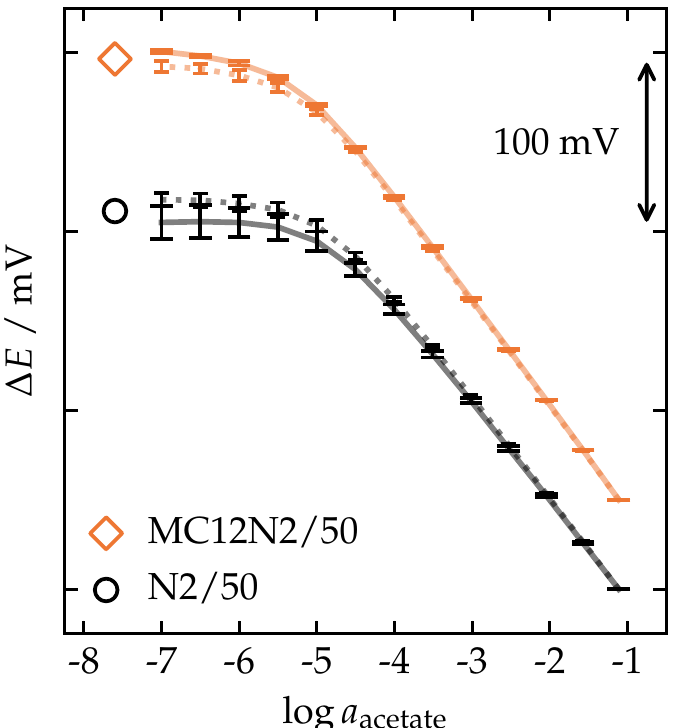
Figure 3. Potentiometric calibrations of sensors with either the best-performing ion-selective membrane or its corresponding control membrane. Potentials have been adjusted to separate membranes and so that each sensor in a group starts at the same potential at log a = − 1.11. Error bars express standard deviations. PVC- and PCTFE-shelled sensors are shown as solid lines with wide error bars and dotted lines with narrow error bars, respectively. See Table 1 for membrane compositions.